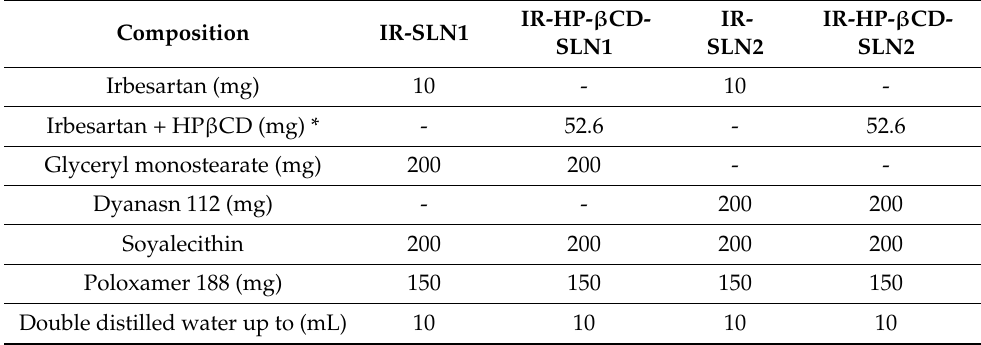
Table 3. Composition of irbesartan and irbesartan-HP β CD complexed solid lipid nanoparticle formulations.